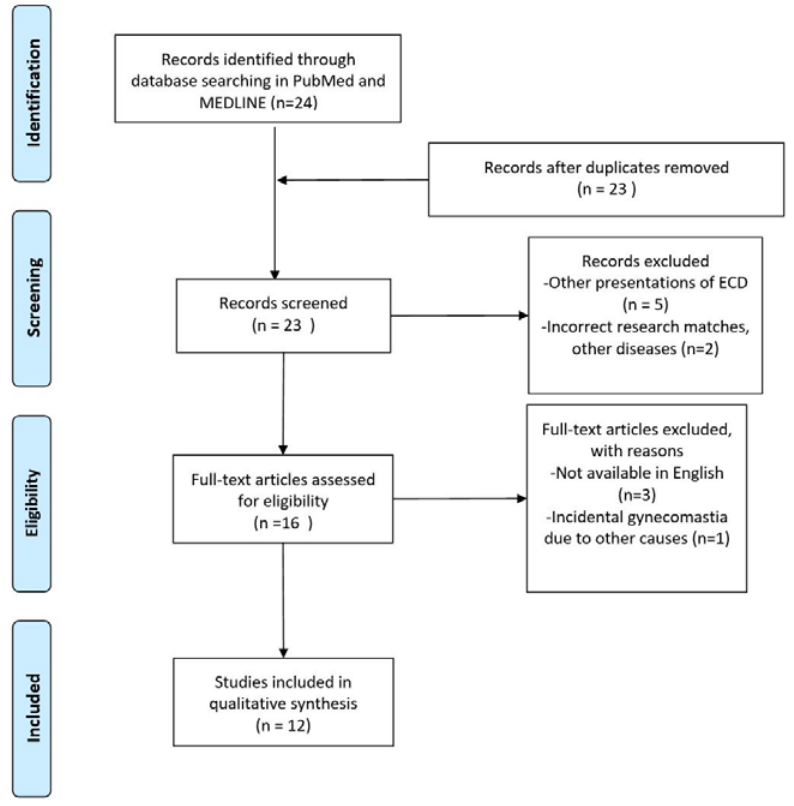
Figure 6. PRISMA flow diagram.